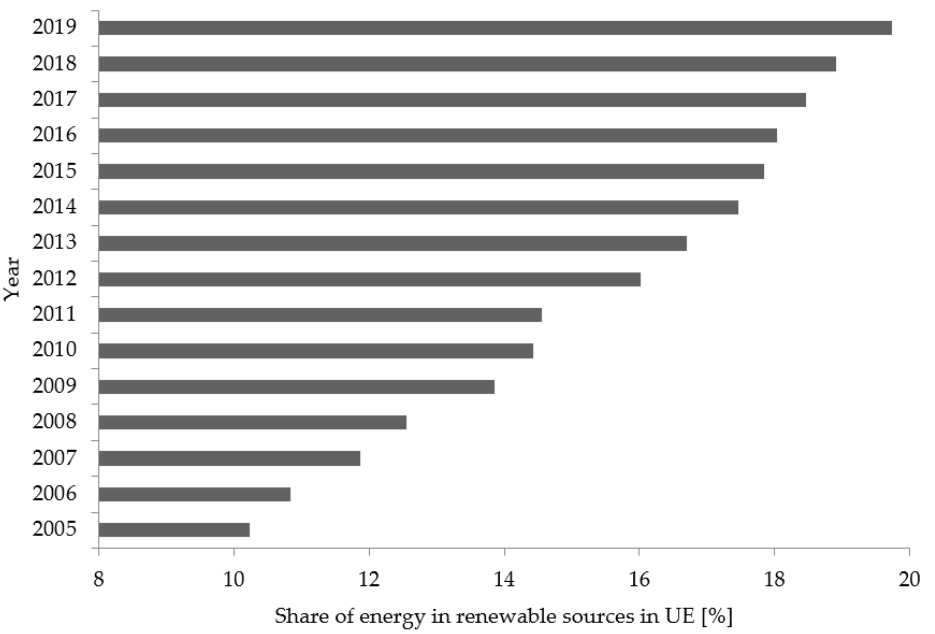
Figure 1. Share of renewable energy in the total energy production in the European Union in 2005–2019. Adapted from Ref. [4].